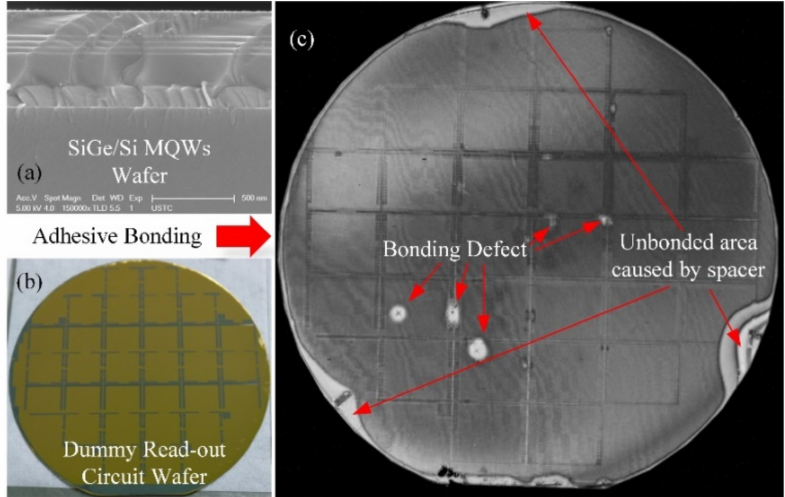
Figure 4. Sketch of the heterogeneous integration between SiGe/Si MQWs wafer and read-out wafer: ( a ) The cross-section of SiGe/Si MQWs wafer; ( b ) The overview of dummy read-out circuit wafer; ( c ) The ultrasonic micrograph of bonded